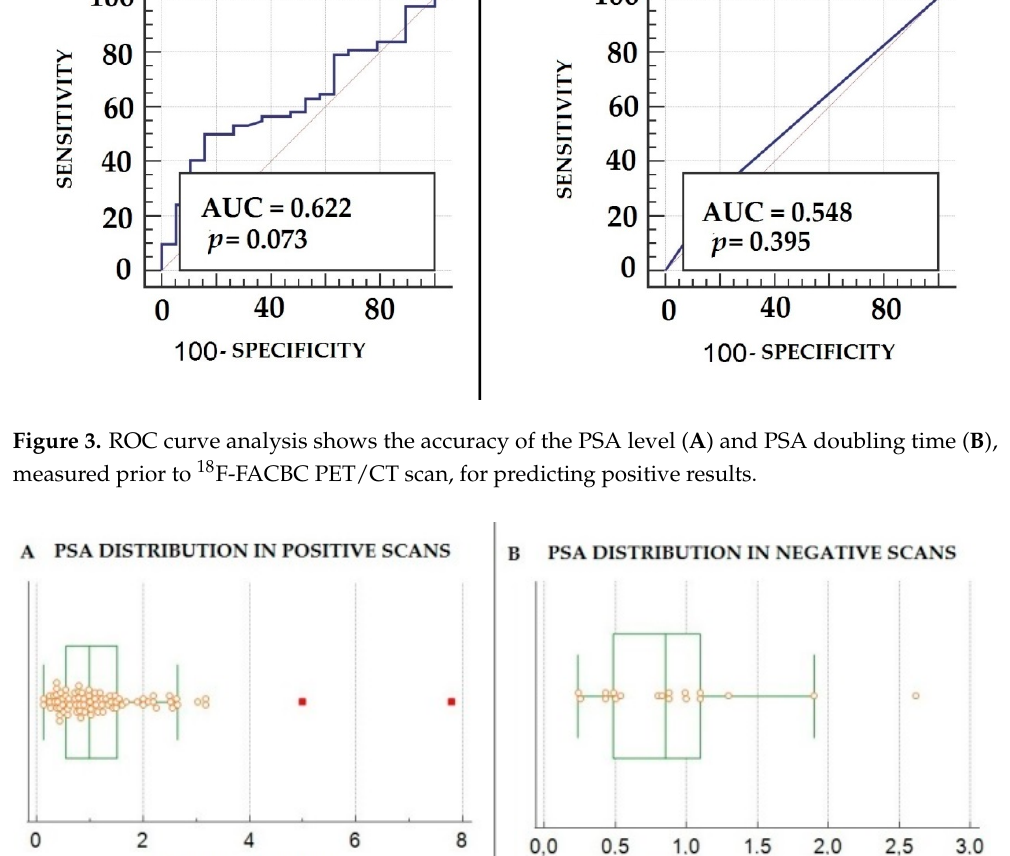
Figure 3. ROC curve analysis shows the accuracy of the PSA level ( A ) and PSA doubling time ( B ), measured prior to 18 F-FACBC PET/CT scan, for predicting positive results.